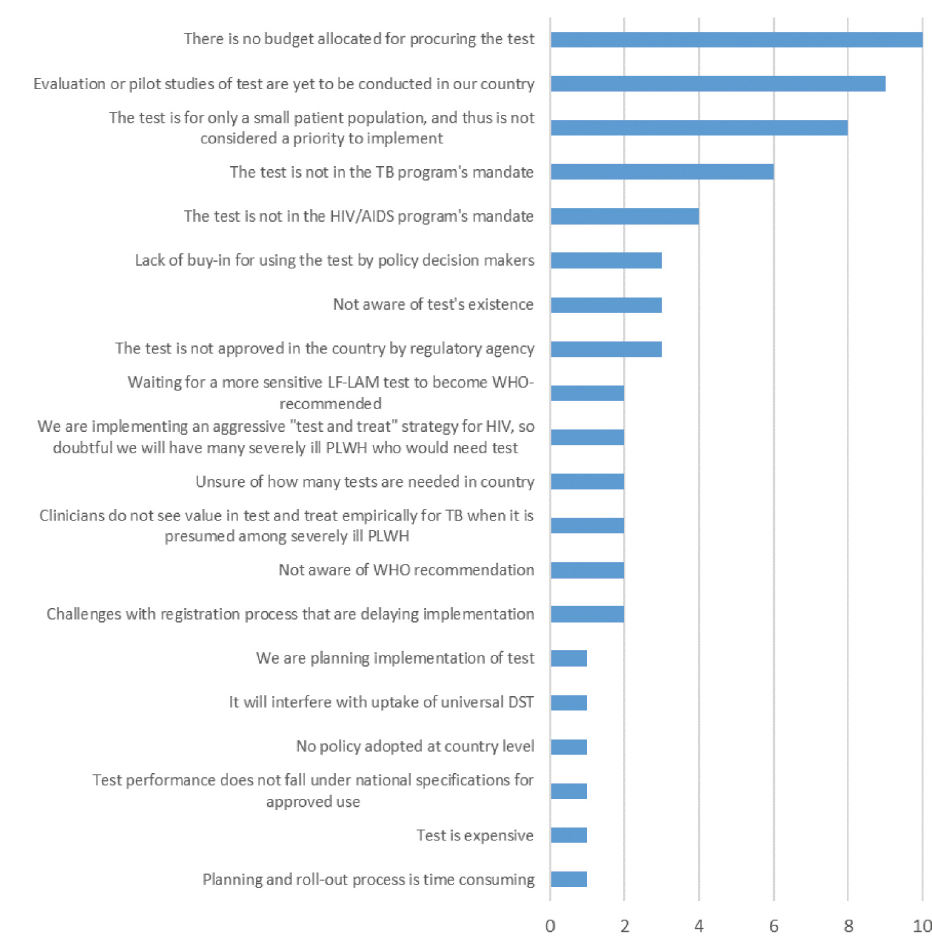
Figure 2. Barriers to Alere-LAM urine test use. Questionnaire included a set list of barriers and allowed respondents to report other barriers not included. Unique barriers per country are reported here. For example, if two surveys from one country listed the same barrier, it was only included